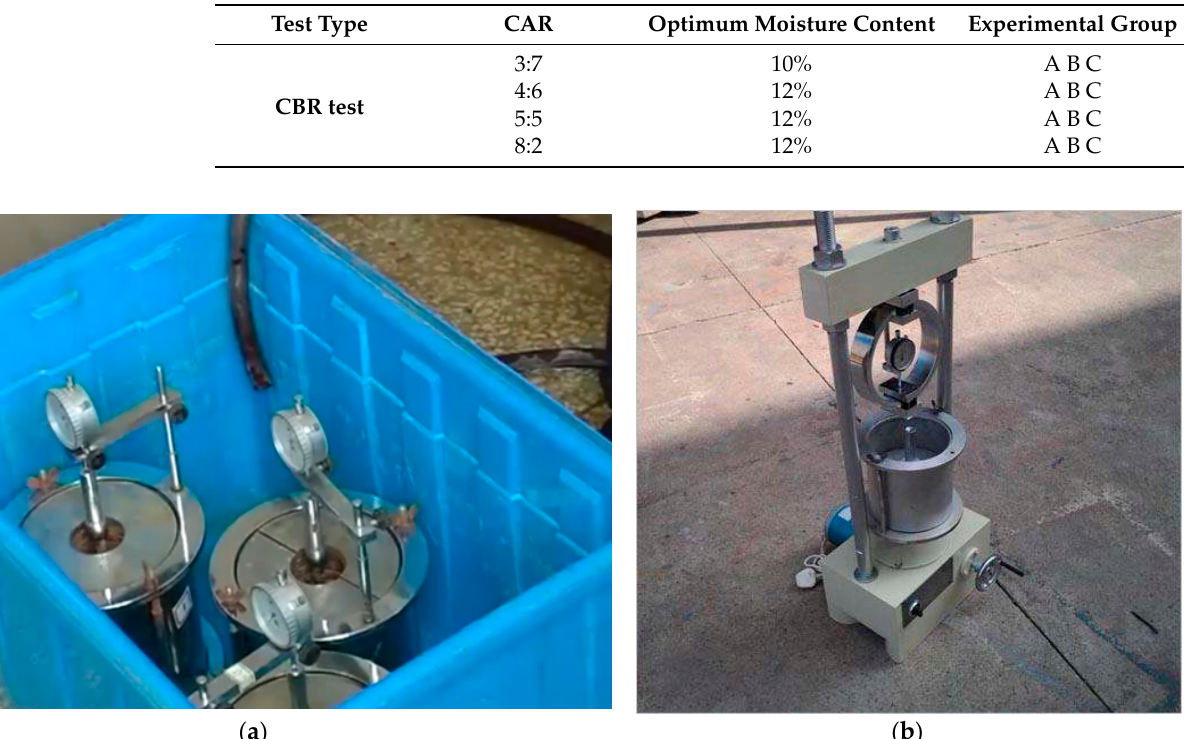
Table 4. CBR test design.